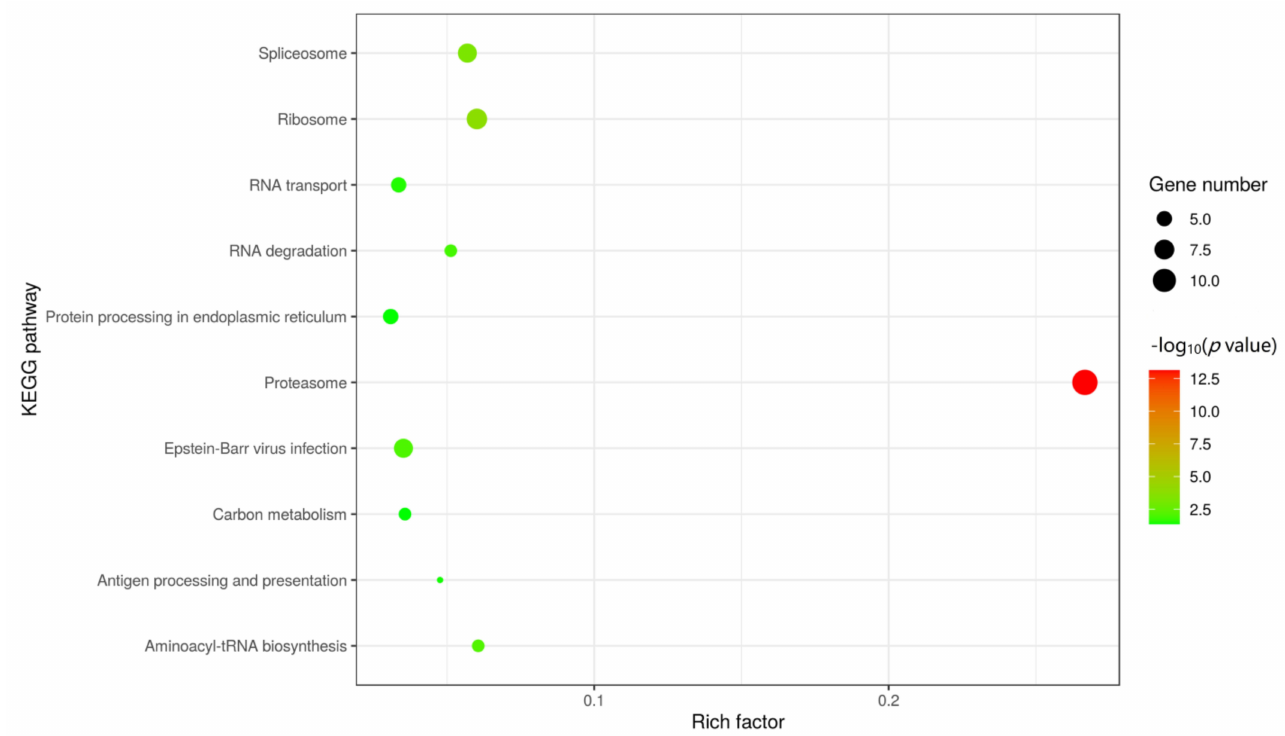
Figure 4. KEGG pathway enrichment analysis. The enriched pathways targeted by ASFV MGF360-9L-interacting proteins were analyzed using the KEGG functional annotation pathway database. The terms that were significantly enriched ( p < 0.05) were